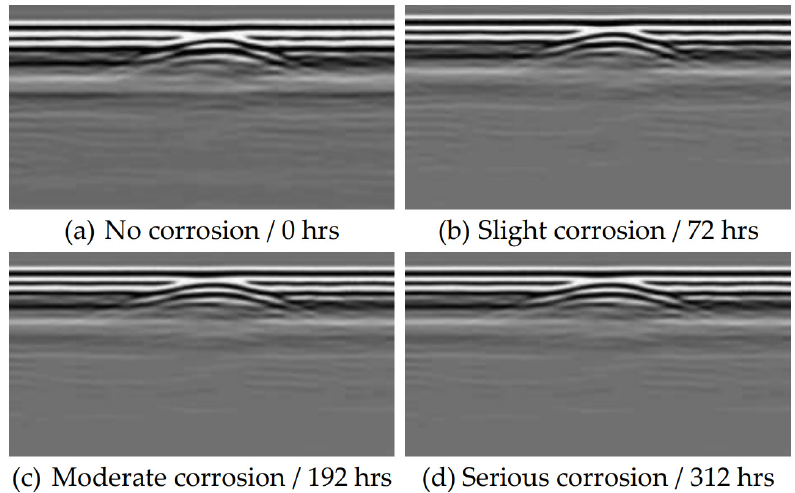
Figure 10. GPR Scanning Profile of Steel Bar Corrosion (thickness of 6 cm).